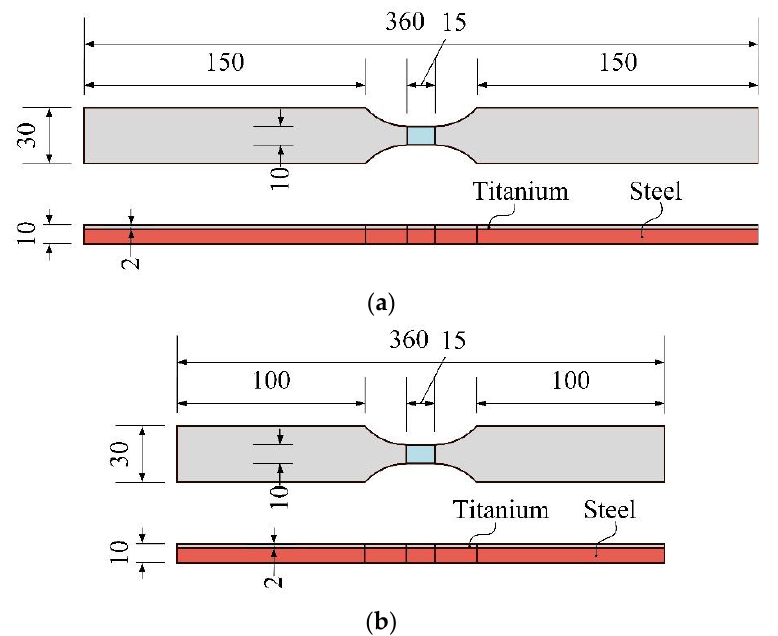
Figure 5. Geometry of high-cycle fatigue test specimens: ( a ) HCF-EB-HBS and HCF-HR-LBS; ( b ) HCF-HR-HBS [16].